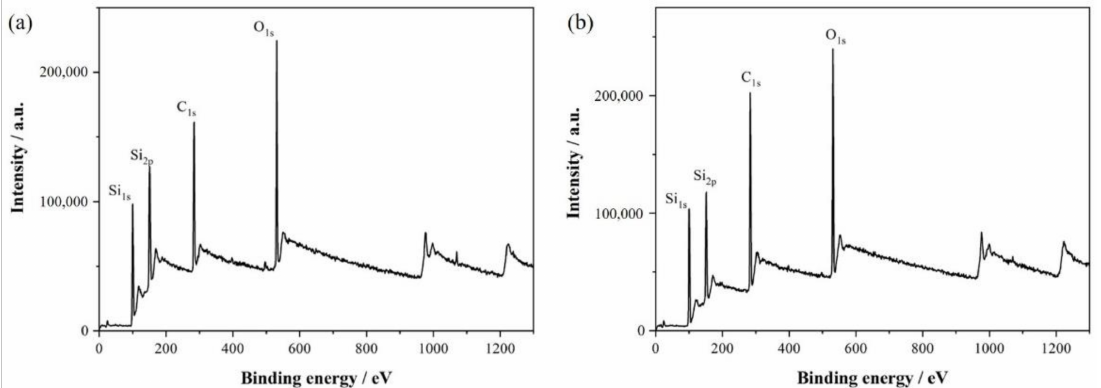
Figure 2. The survey scan of the XPS: ( a ) the SiC amorphous films obtained by removing the AAO; ( b ) the SiC nanoarrays obtained by vacuum